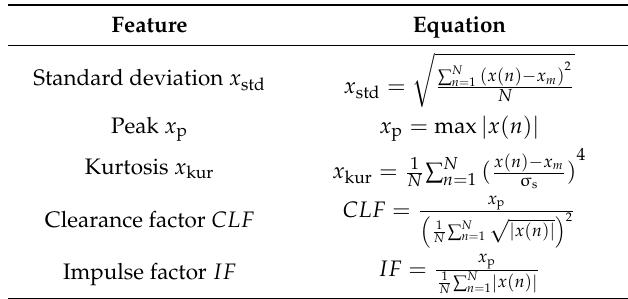
Table 1. Five time domain feature parameters 1 .